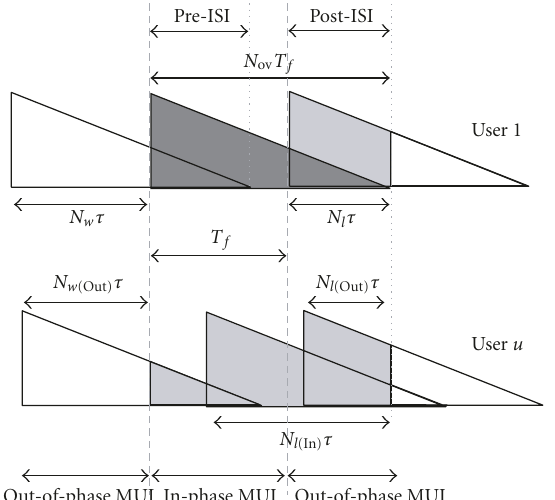
Figure 6: Path alignment parameters for ISI and MUI variance for- mulation.